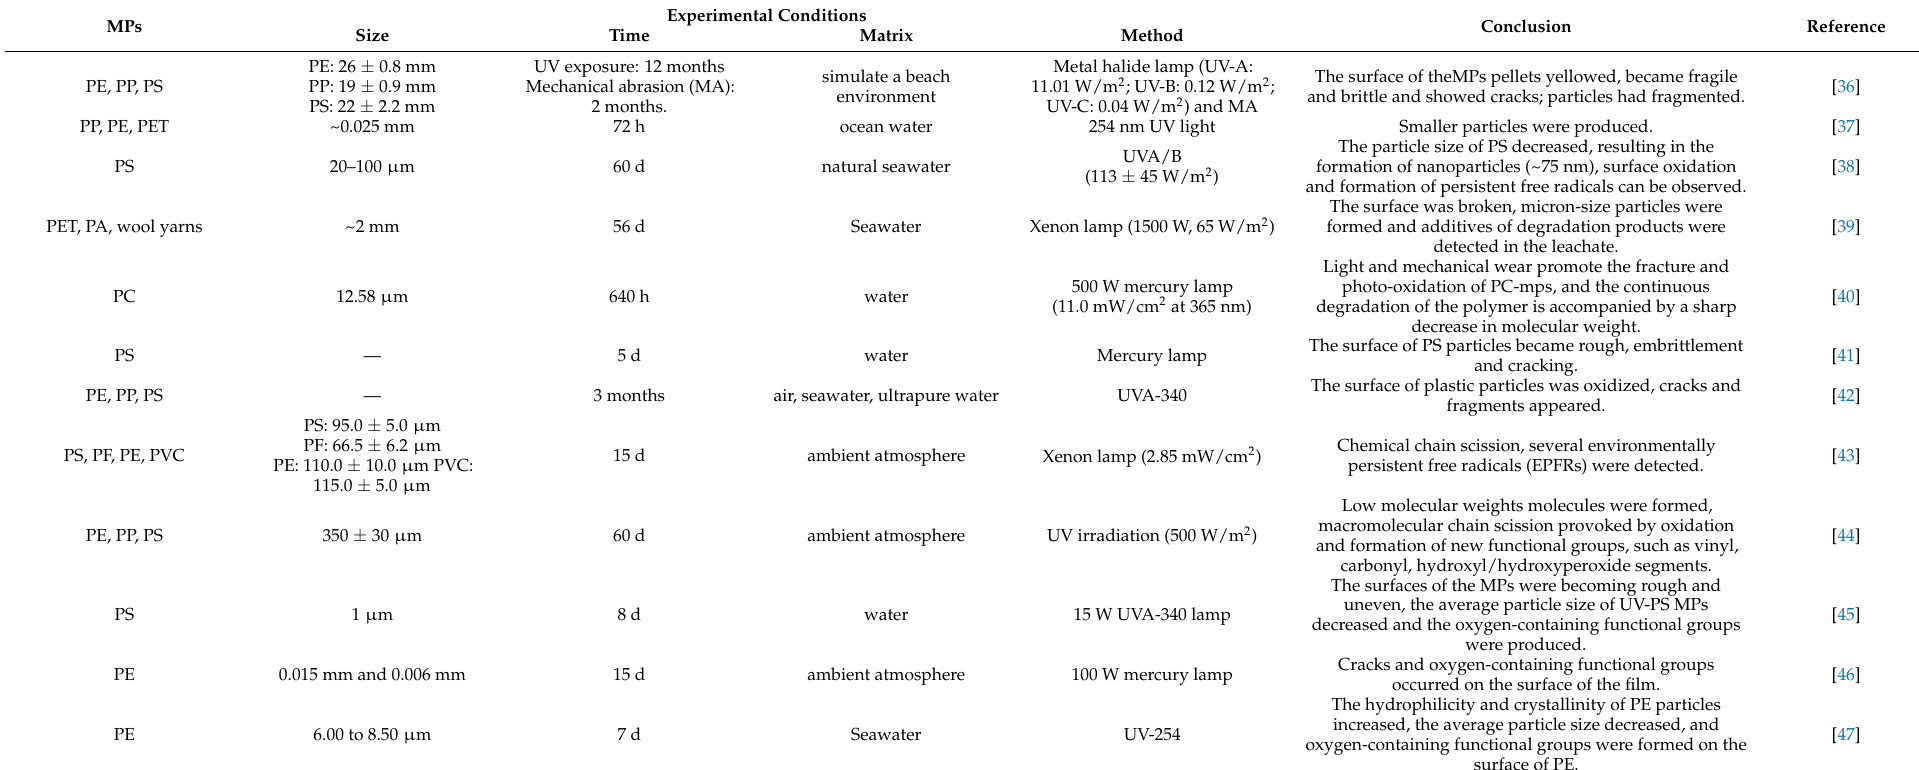
Table 1. Photoaging process of MPs under different environmental